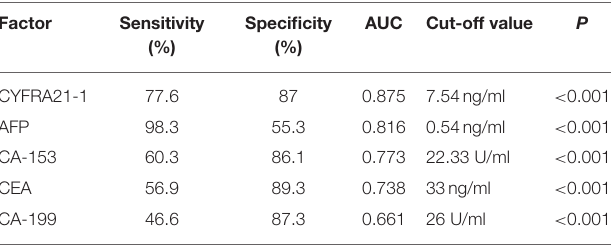
TABLE 4 | Sensitivity, specificity, AUC, and cut-off values for tumor markers as diagnostic indicators.